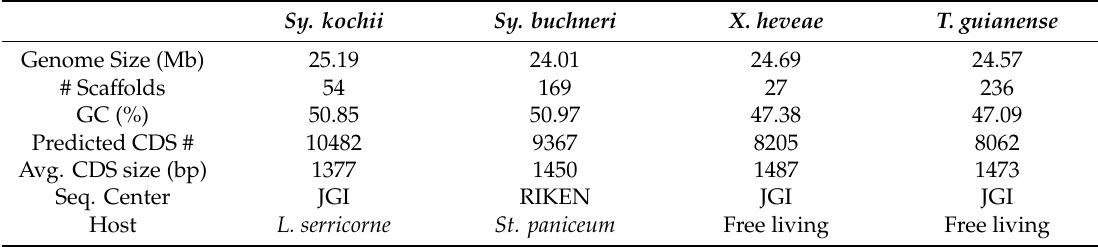
Table 4. Comparative genomics among